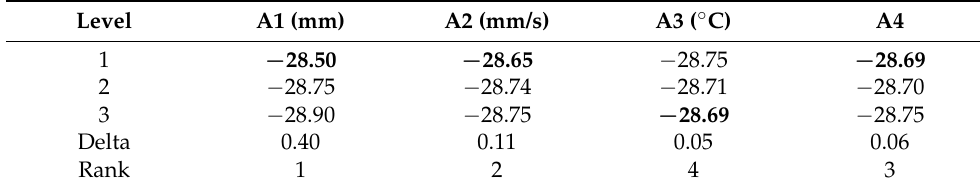
Table A4. Mean S/N ratio response table for Rq-PA-6 polymer.